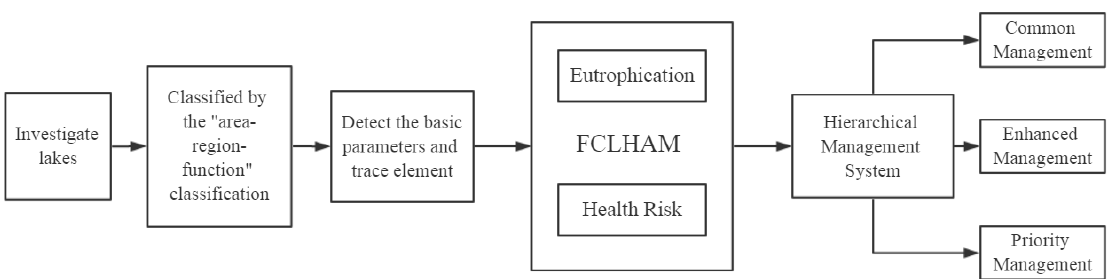
Figure 3. Workflow of the established hierarchical management system.